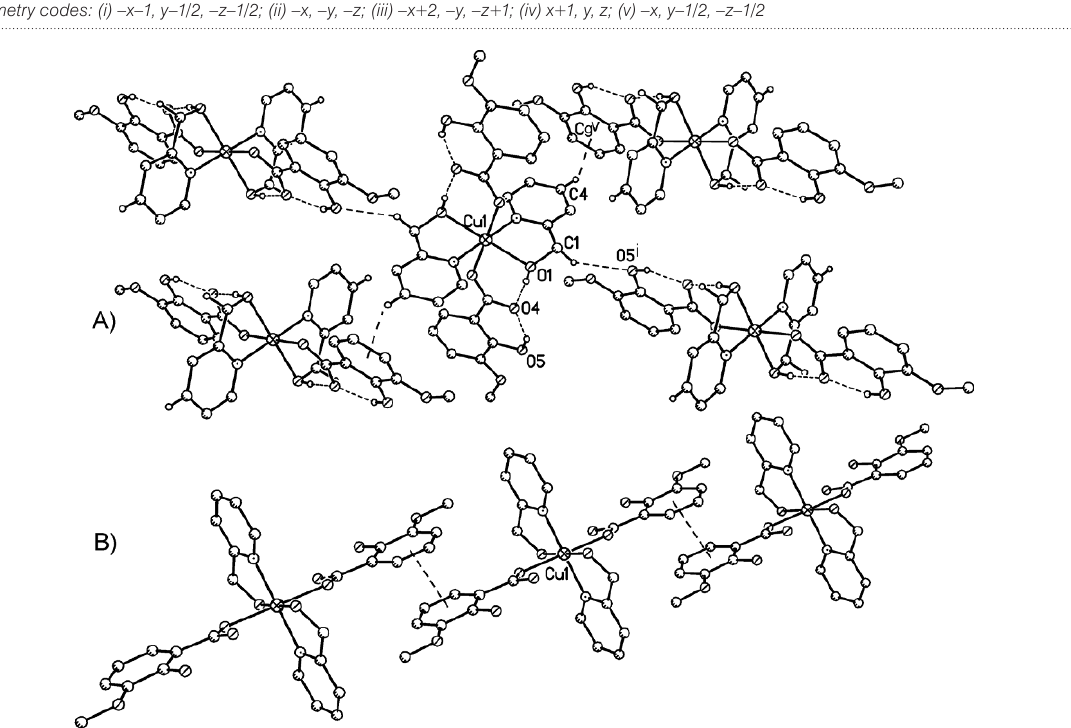
Figure 4. Crystal packing of [Cu(3-MeOsal) (2-pyme) ] (1) . Hydrogen atoms are omitted for clarity. A) The O—H···O, C—H···O and C—H···Cg 2 2 (CH\ π ) hydrogen bonds in crystal structure of 1 . B) The π – π stacking interactions between benzene rings of